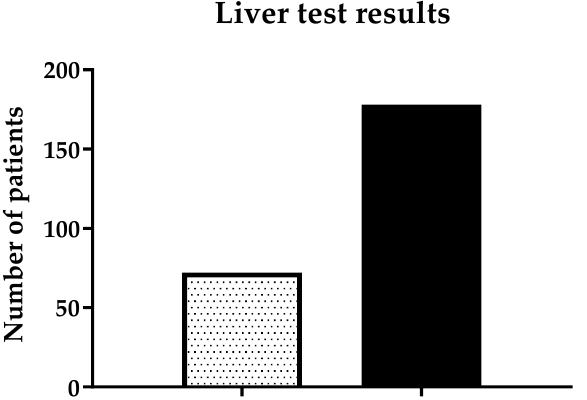
Figure 2. The liver function test results of all the participants.